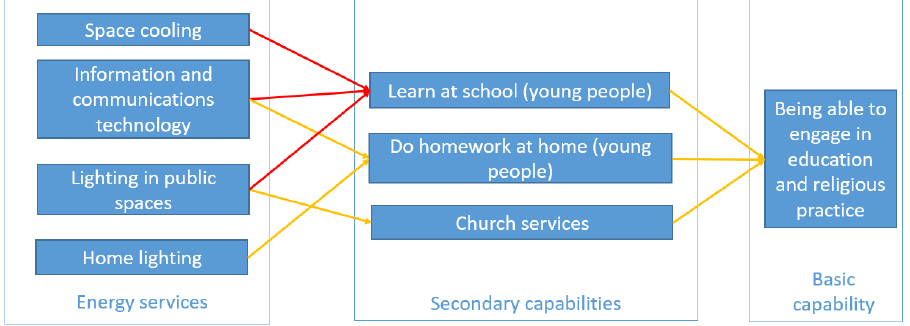
Figure 5. Connections made between energy services, secondary capabilities, and education and religious